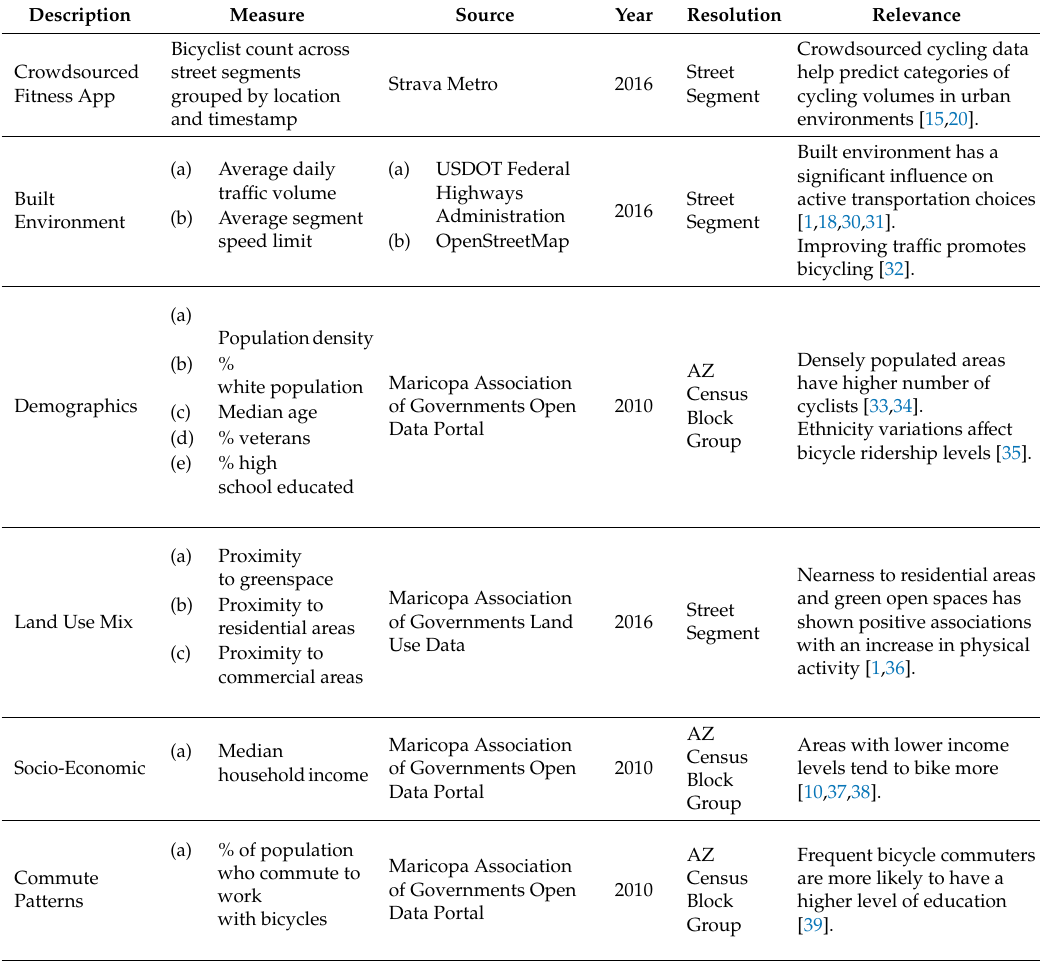
Table 1. Geographical covariates influencing ridership in Maricopa County